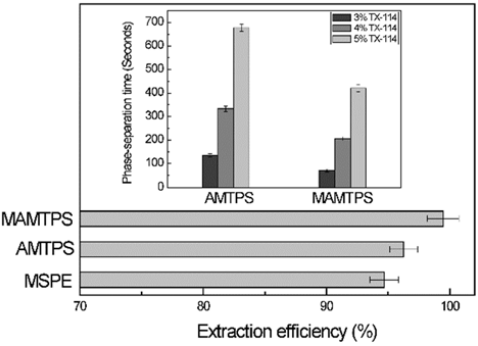
Figure 8. Comparison of the extraction efficiency of CR and phase-separation time of magnetic aqueous micellar two-phase system (MAMTPS) to magnetic solid phase extraction (MSPE) and aqueous micellar two-phase system (AMTPS). (The MAMTPS contained 10 mL CR (1 mg/mL), 4 mg Fe 3 O 4 @NH 2 , 4 wt. % TX-114, 40 min vibration time, and incubated at temperature 40 ◦ C for 10 min; the AMTPS contained 10 mL CR (1 mg/mL), 4 wt. % TX-114, 40 min vibration time, and incubated at temperature 40 ◦ C for 10 min, the MSPE contained 10 mL CR (1 mg/mL), 10 mg Fe 3 O 4 @NH 2 , 4 h vibration time). The phase-separation time was determined at 3–5 wt. % TX-114 and 30 ◦ C water